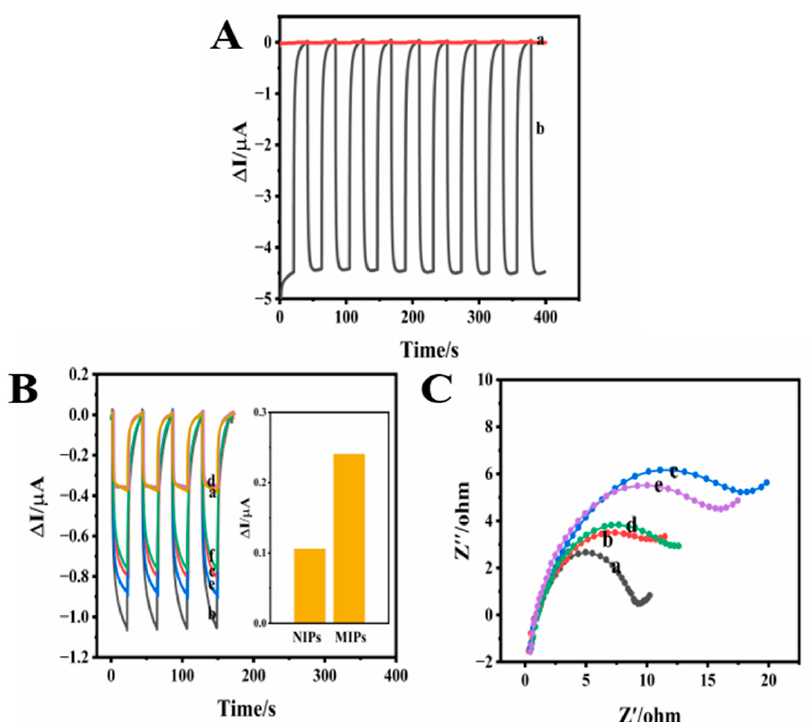
Figure 2. ( A ) The photocurrent comparison of β -Bi 2 O 3 in 0.1 M Na 2 SO 4 electrolyte under a light intensity of 500 W m − 2 without (a) and with 10 − 4 M K 3 [Fe(CN) 6 ] (b). ( B ) Photoelectrochemical behaviors of MIP and NIP. MIP/ β -Bi 2 O 3 /ITO photocurrent responses after polymerization (a), after the elution of BPA (b), after the re-recognition of BPA (c); NIP/ β -Bi 2 O 3 /ITO photocurrent responses after polymerization (d), after the elution step (e) and after the incubation with BPA (f). The concentration of BPA is 10 nM. ( C ) EIS characterization of ITO (a), β -Bi 2 O 3 /ITO (b), MIP/ β -Bi 2 O 3 /ITO after polymerization (c), after the elution (d) and after the incubation of 10 nM BPA (e) in 5.0 mM [Fe(CN) 6 ] 3 − /4 − solution containing 0.1 M KCl recorded in the frequency range from 0.1 Hz to 10 kHz with an open circuit potential.